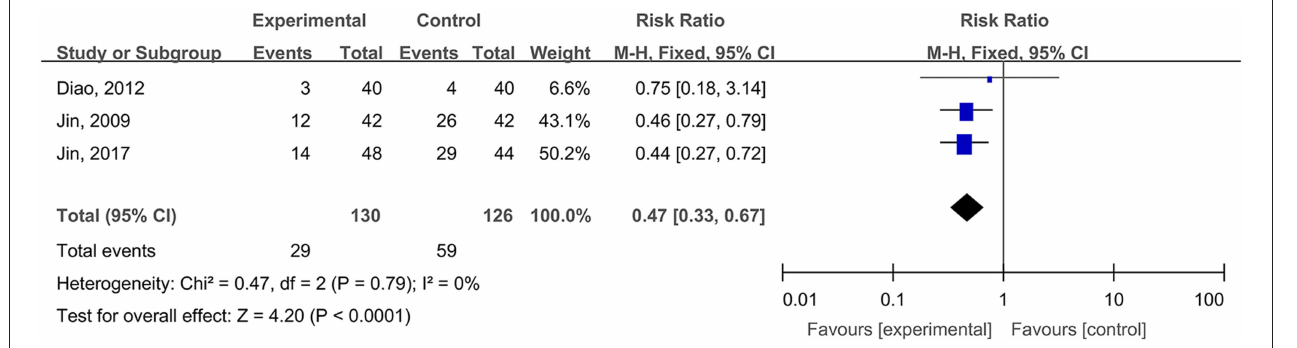
dressings group than in the control group, and that statistically the difference was highly significant (RR = 0.47, 95% CI: 0.33– 0.67, P < 0.0001). Other included studies reported no details about patients’ adverse